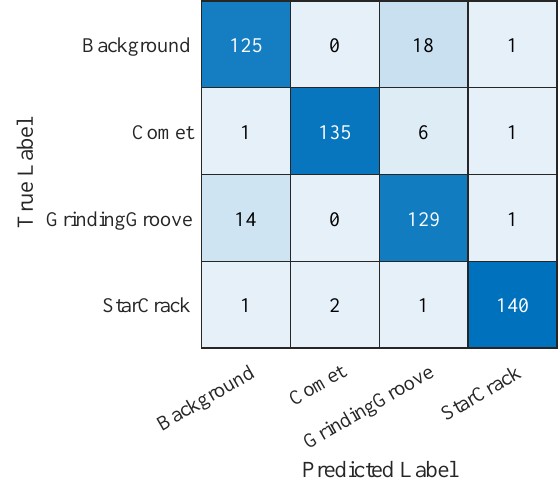
Figure 17. Confusion matrix of ‘CNN 20’ applied on the test samples.